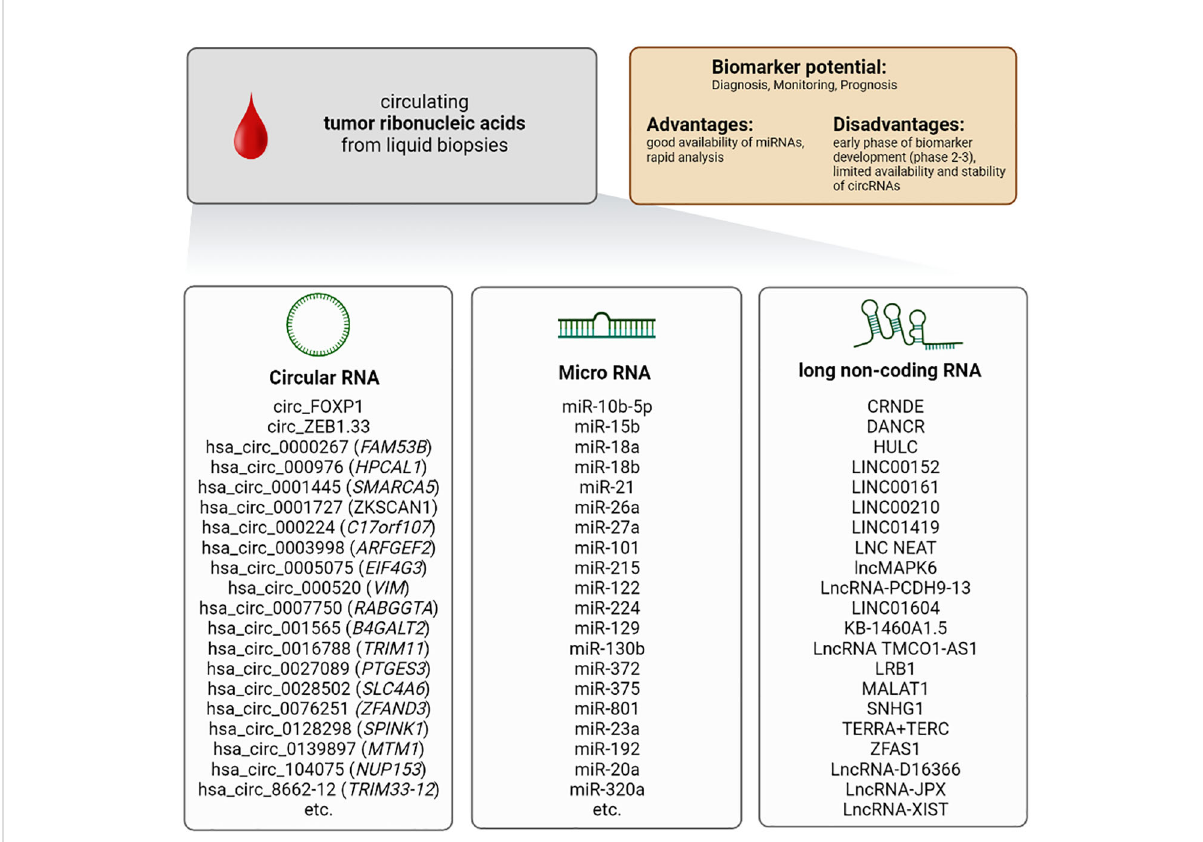
FIGURE 3 Characteristics of the biomarker class circulating tumor ribonucleic acids (cell-free RNA) in patients with